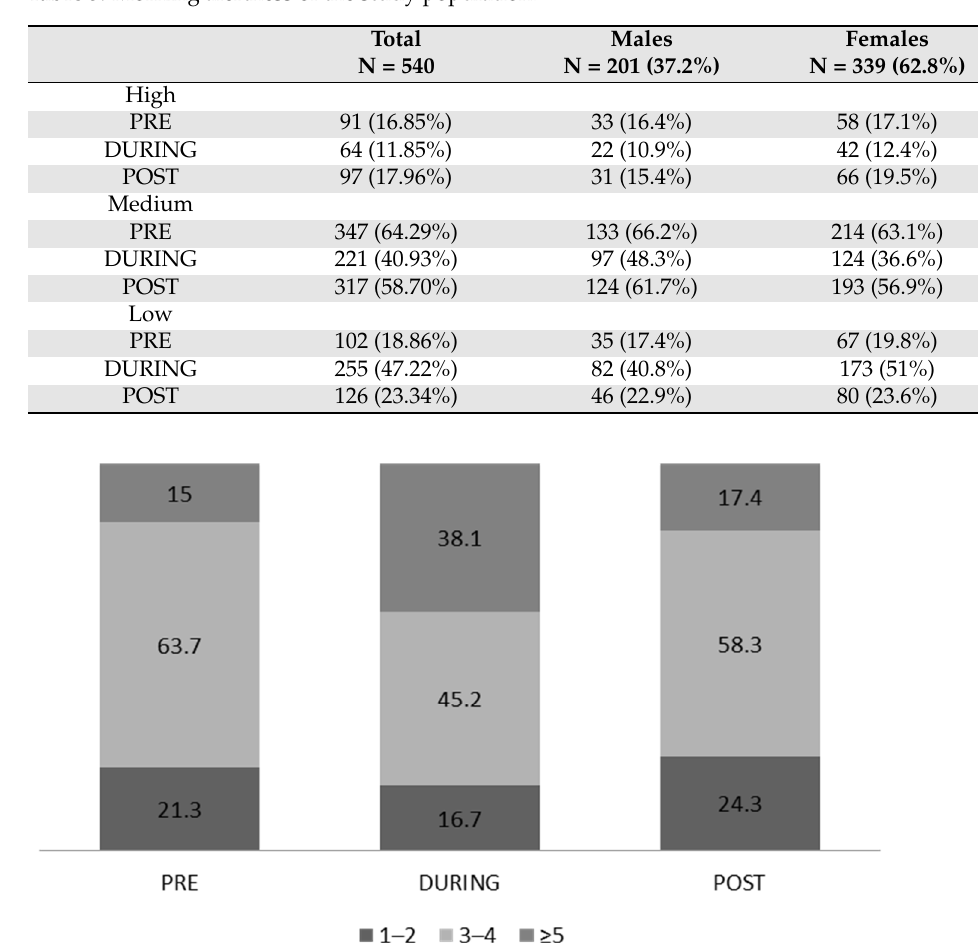
Figure 5. Number of meals per day in the study population.